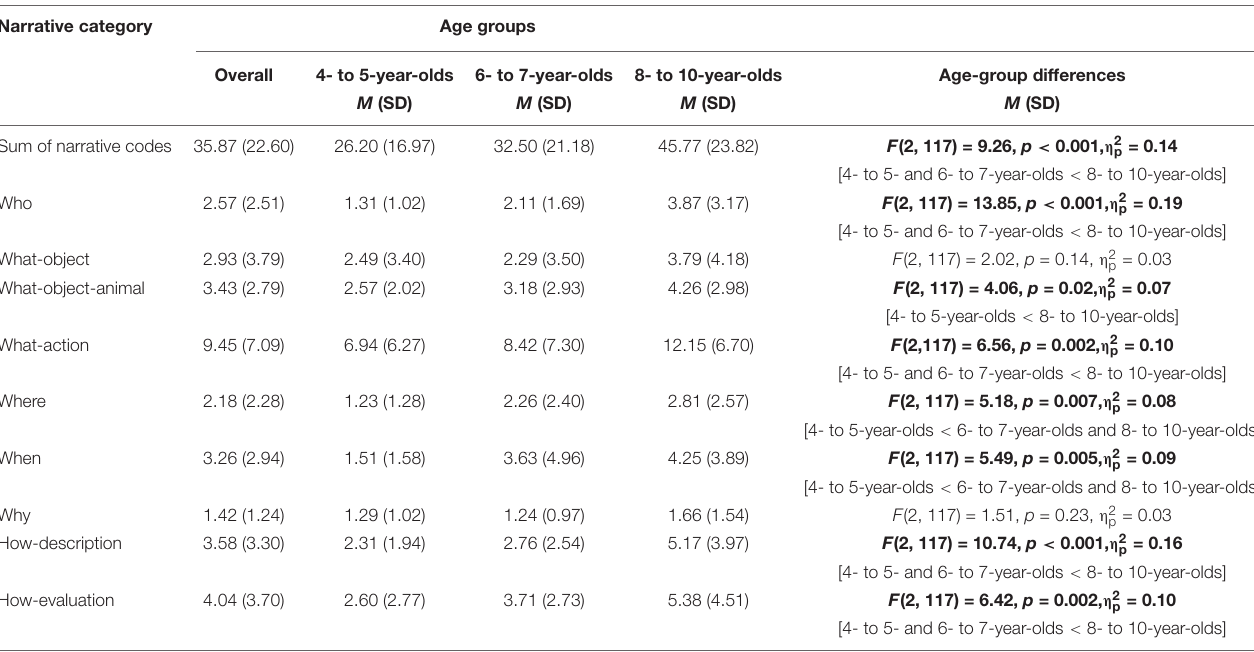
TABLE 4 | Descriptive statistics for each AM code for the child-selected